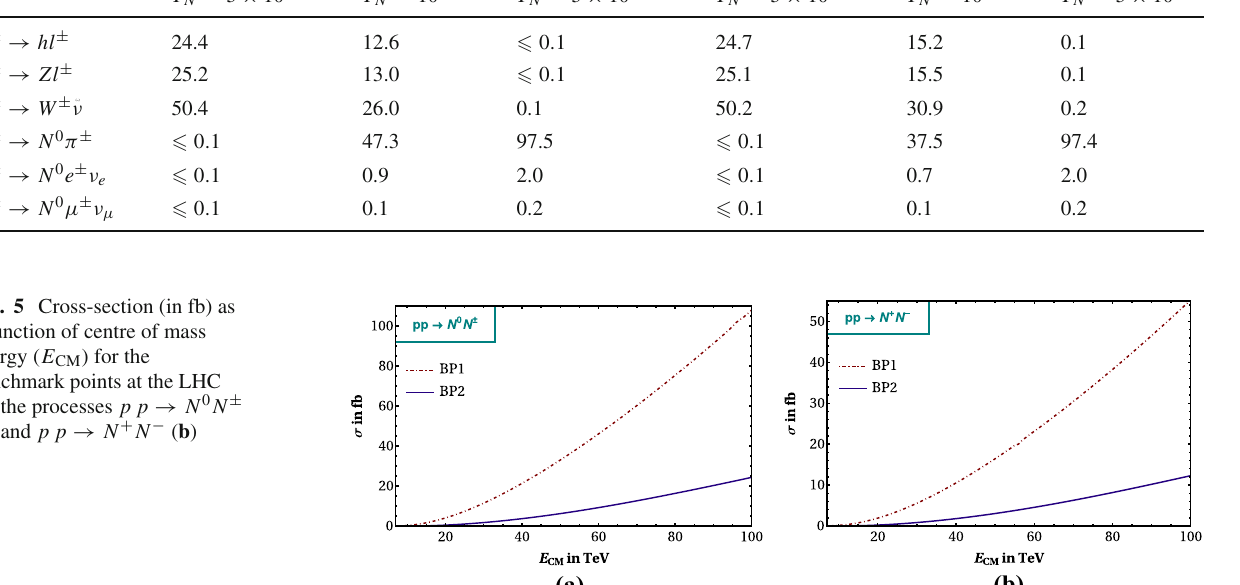
Table 2 Production cross-sections (in fb) with NLO correction of the processes p p → N 0 N ± and p p → N + N − , for the benchmark points at the LHC for 14 TeV, 27 TeV and 100 TeV centre of mass energies Cross-sections (in fb) with the E CM Benchmark